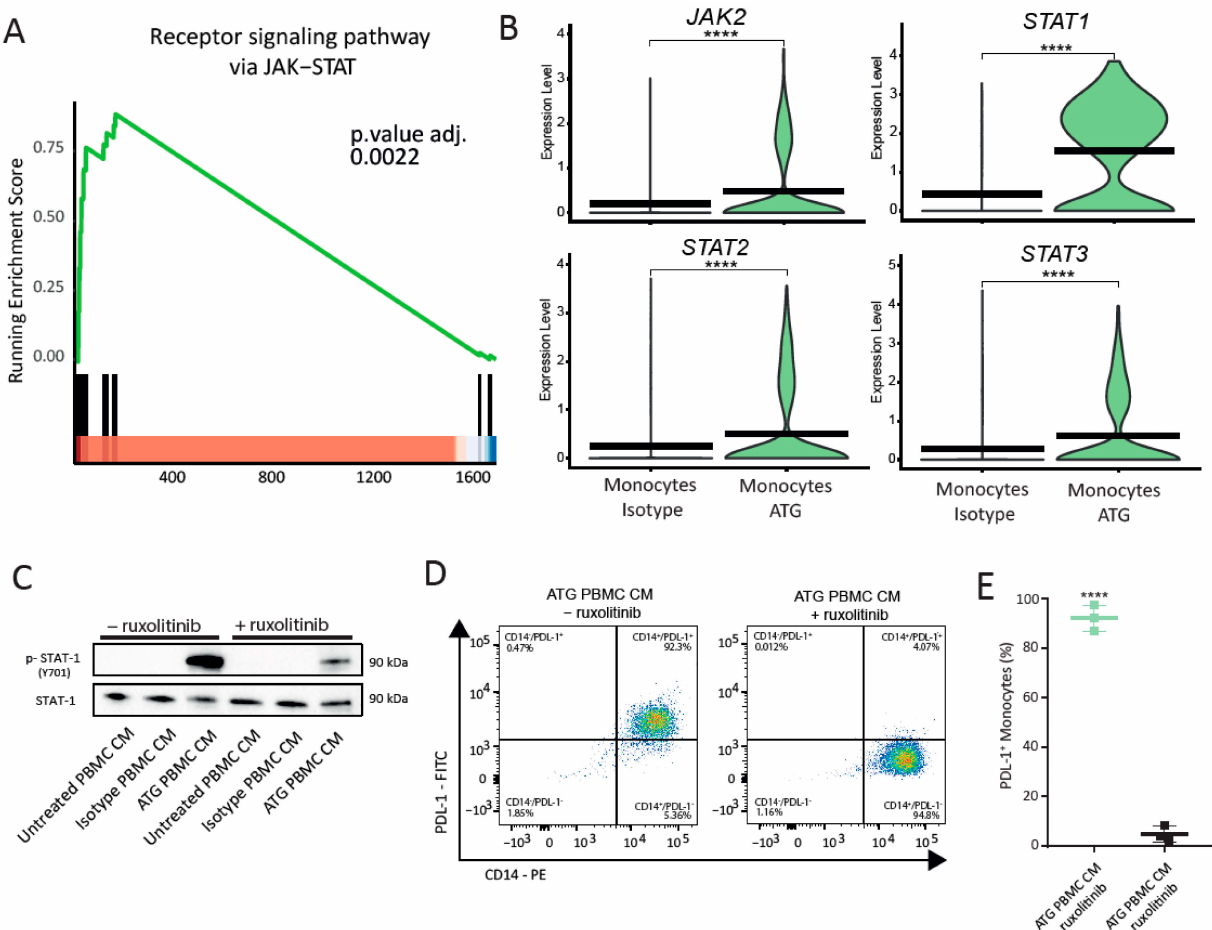
Figure 4. STAT-1 activation is required for the induction of PDL-1 on purified monocytes. ( A ) GSEA enrichment plot for the receptor signaling pathway via JAK-STAT in monocytes from ATG-treated whole blood. The green line depicts the running enrichment score, and the black vertical lines indicate genes responsible for the enrichment and position in the ranked list of DEG. ( B ) Violin plots depicting the differential expression of JAK2 , STAT1 , STAT2 and STAT3 in monocytes following stimulation with ATG. Expression levels are indicated by violin plot height, while width represents the proportion of positive cells. Crossbars mark mean expression. **** indicates p -value < 0.0001. ( C ) Representative Western blots of purified monocytes pretreated with the JAK/STAT inhibitor ruxolitinib for 1 h before stimulation with conditioned media of ATG-treated PBMCs and controls. The levels of total STAT1 and phosphorylated STAT1 were assessed after 2 h. ( D ) FACS plots showing the percentage of monocytes positive for PDL-1 24 h after the addition of conditioned medium of ATG-treated PBMCs with and without the prior addition of ruxolitinib. ( E ) Quantitative analysis for surface expression of PDL-1 on monocytes in the investigated conditions for N = 3 donors. Asterisks denote p -values < 0.0001. Student’s t -test was used to determine